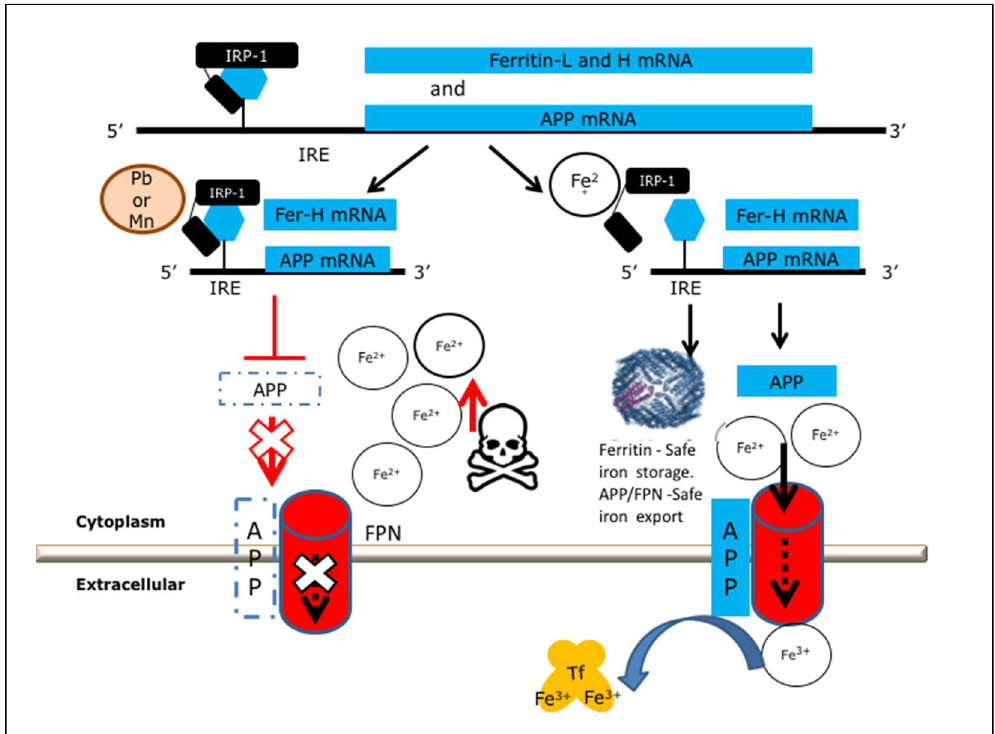
Figure 1. Model for the use of 5’untranslated region directed small molecules as therapeutic agents to offset lead neurotoxicity. These are depicted to act via the pathway to activate amyloid precursor protein (APP) and ferritin translation, preventing each of them from maintaining iron homeostasis and iron storage and export functions. Lead blocks translation of APP and thus interferes with ferroportin (FPN)-dependent iron export which normally results in neuroprotective consequences [32]. APP is an iron export protein associated with the onset of Parkinson’s disease with dementia in the event of the loss of tau microtubule associated protein [33]. Adapted from Rogers, et al. 2016, A role for amyloid precursor protein translation to restore iron homeostasis and ameliorate lead (Pb) neurotoxicity. J. Neurochemistry , 138 , 479–494 [27].